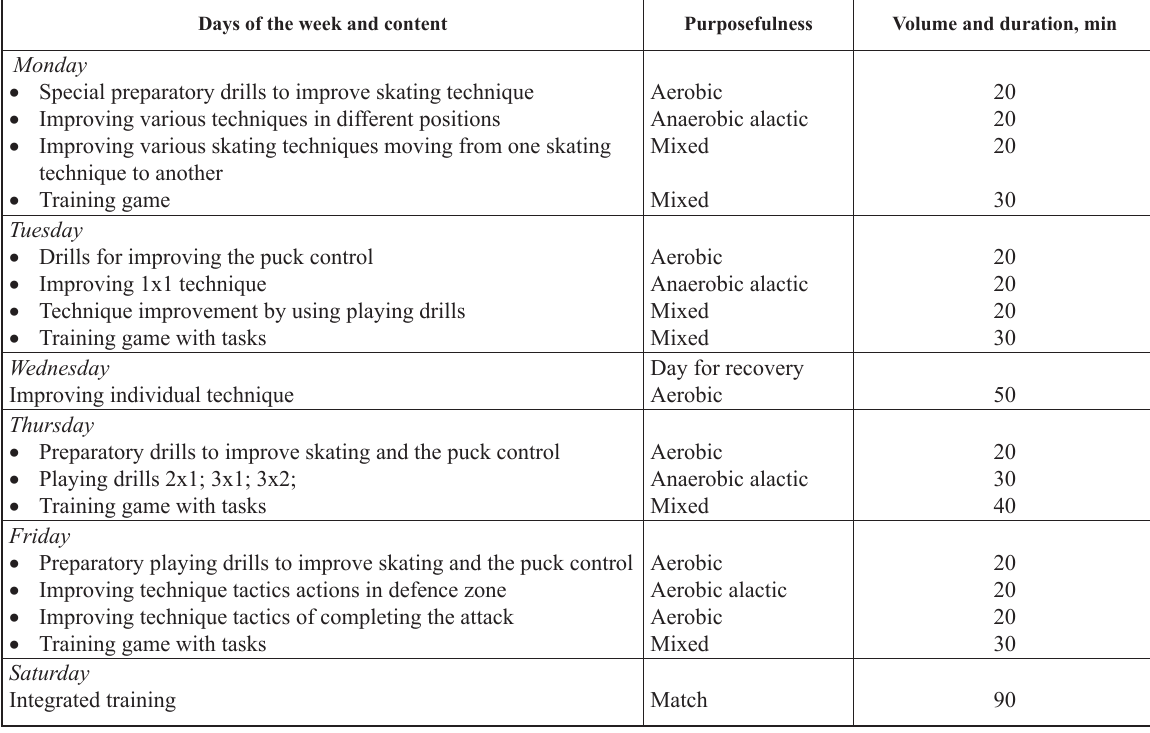
Table 3. Sample of micro-cycle weekly plan in the special training period of the preparatory stage Days of the week and